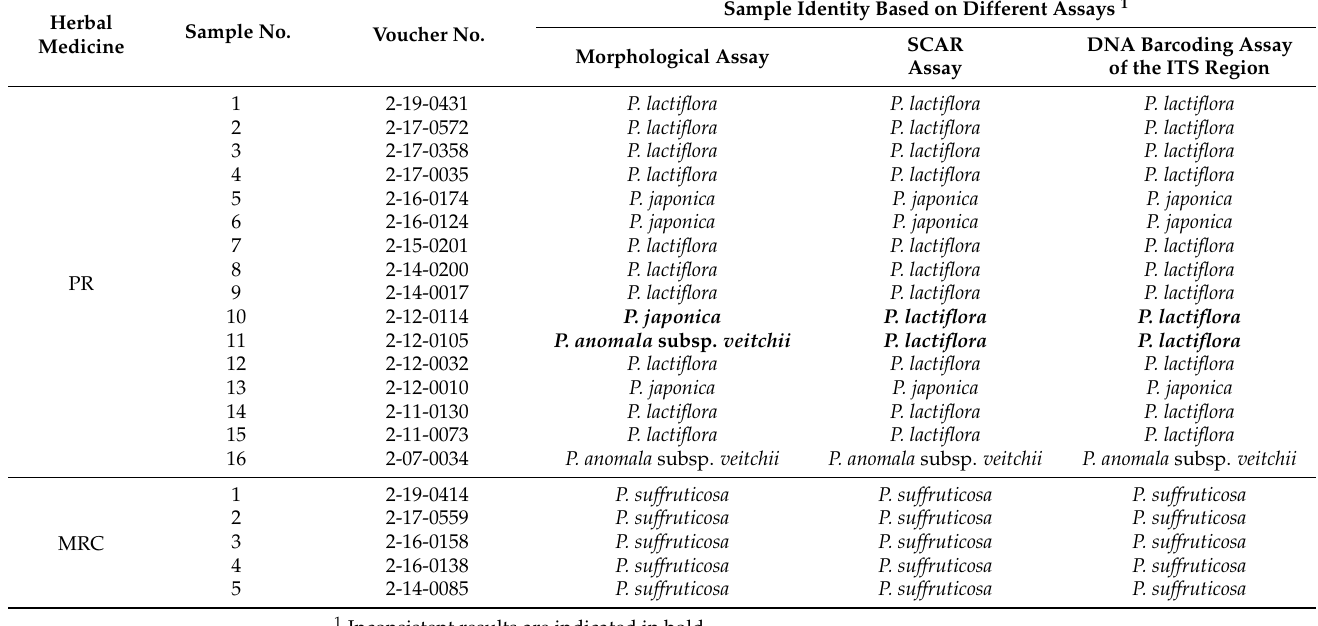
Table 3. Morphological and genetic evaluation of herbal medicines sold as PR and MRC in the Korean herbal market.